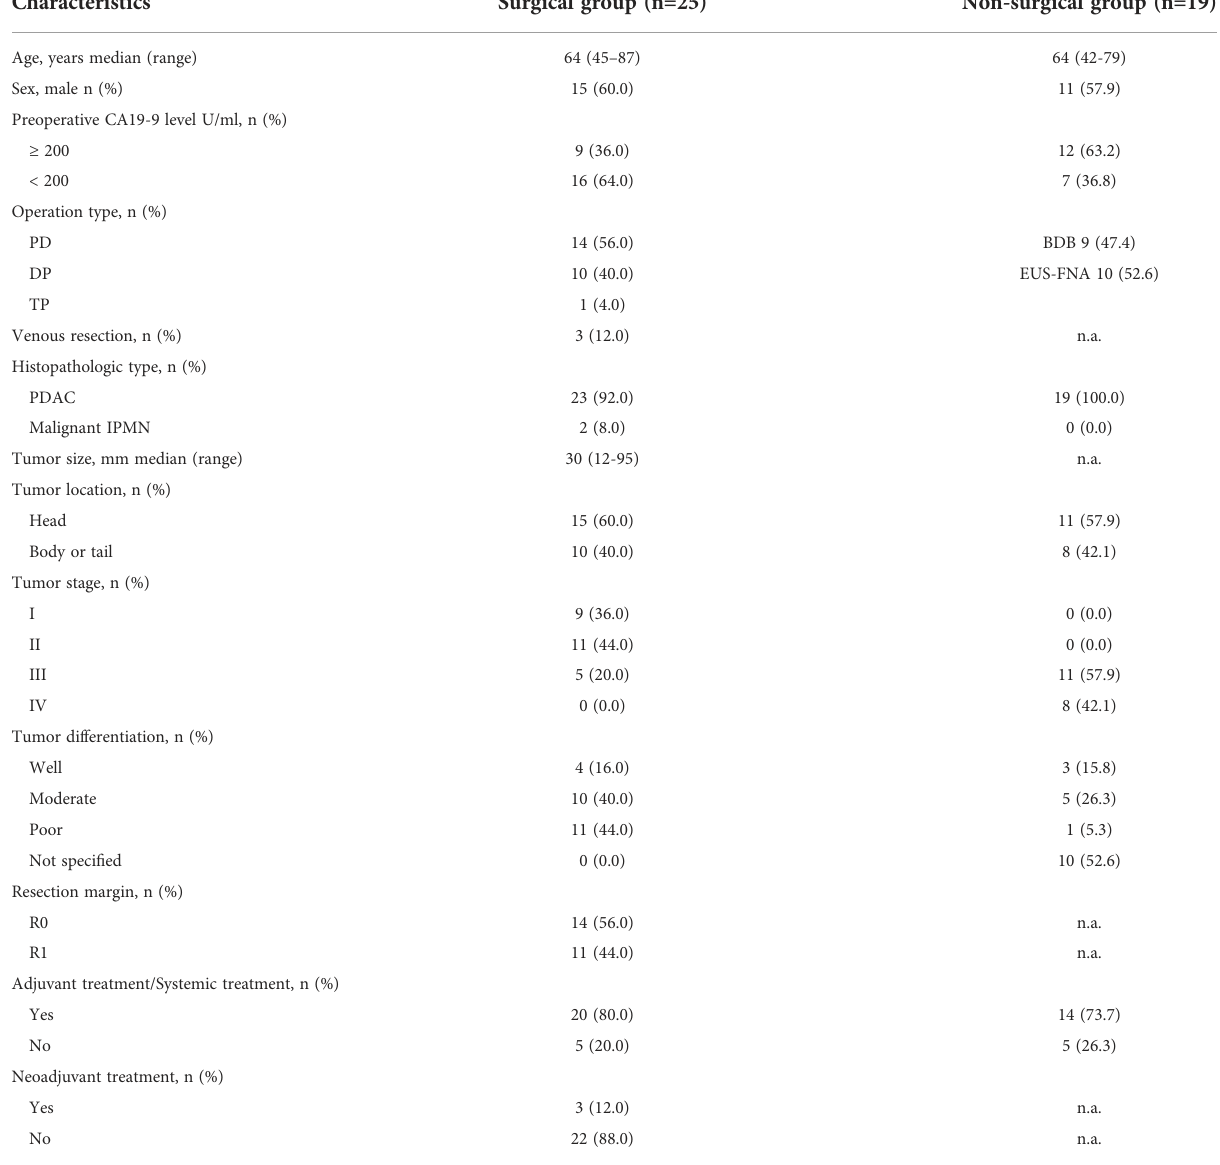
TABLE 1 Demographics, clinicopathologic, and treatment characteristics of included patients.